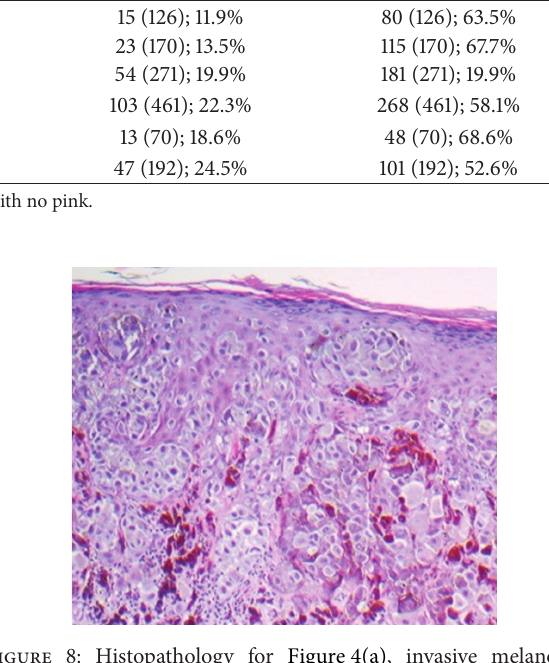
Figure 8: Histopathology for Figure 4(a), invasive melanoma 0.80 mm depth.